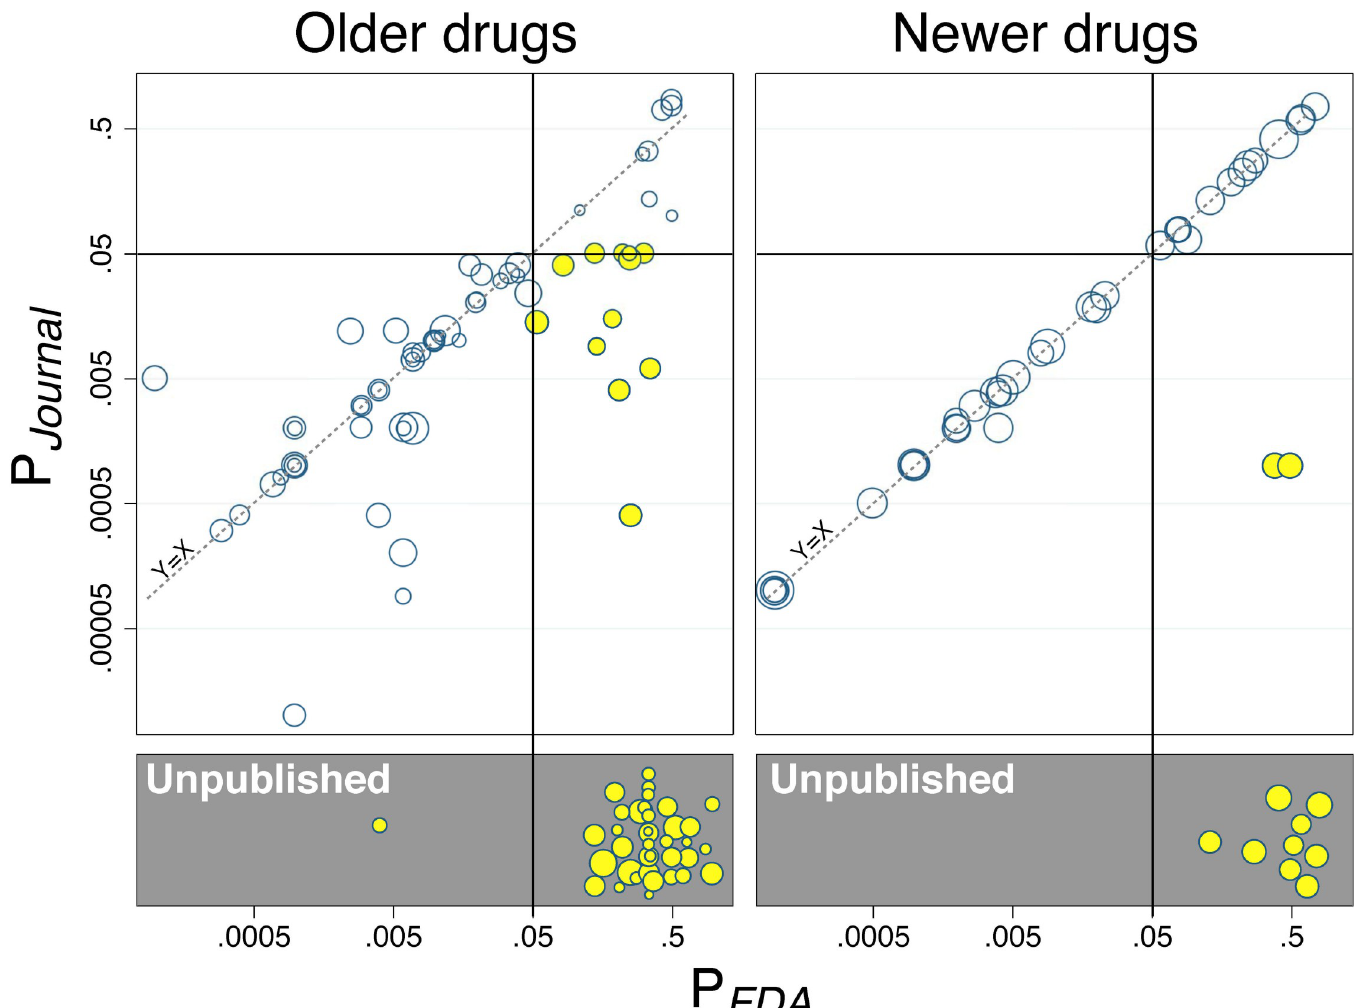
Fig 1. Reporting of P values in publications vs. FDA reviews for older and newer cohorts of antidepressant drugs. P values reported by the FDA (P FDA , horizontal axes) are compared to those in corresponding journal articles (P Journal , vertical axes). The older and newer antidepressants are shown in the left and right plots, respectively. Each data point represents a drug treatment arm compared to placebo, with area proportional to the sum of their sample sizes. Dashed diagonal represents concordance between P FDA and P Journal , i.e., an absence of reporting bias. Cases of outcome reporting bias, where P FDA is NS but P Journal is reported as significant, are highlighted in yellow. (The 2 yellow circles far off the Y = X diagonal in the right-hand panel represent desvenlafaxine trials 309 and 317 (please see text).) Unpublished treatments arms, with P FDA values but no corresponding P Journal values, are shown in the gray boxes and highlighted in yellow. FDA AU : AbbreviationlistshavebeencompiledforthoseusedinFigs 1 (cid:0) 4 : Pleaseverifythatallentriesarecorrect : , Food and Drug Administration; NS, not significant.